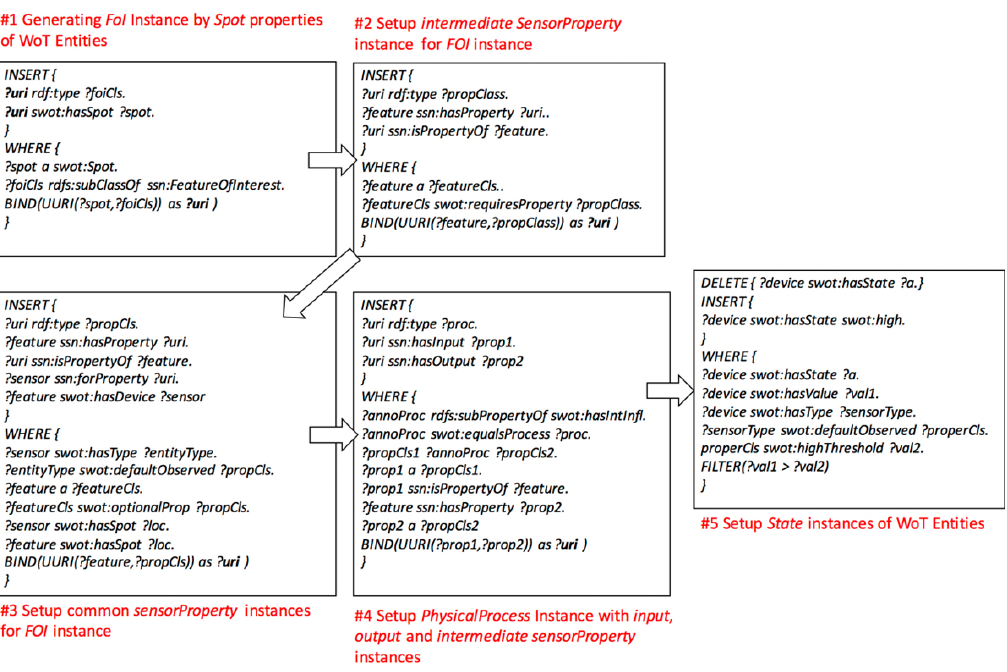
Figure 9. Creating the FoI and PhysicalProcess model.